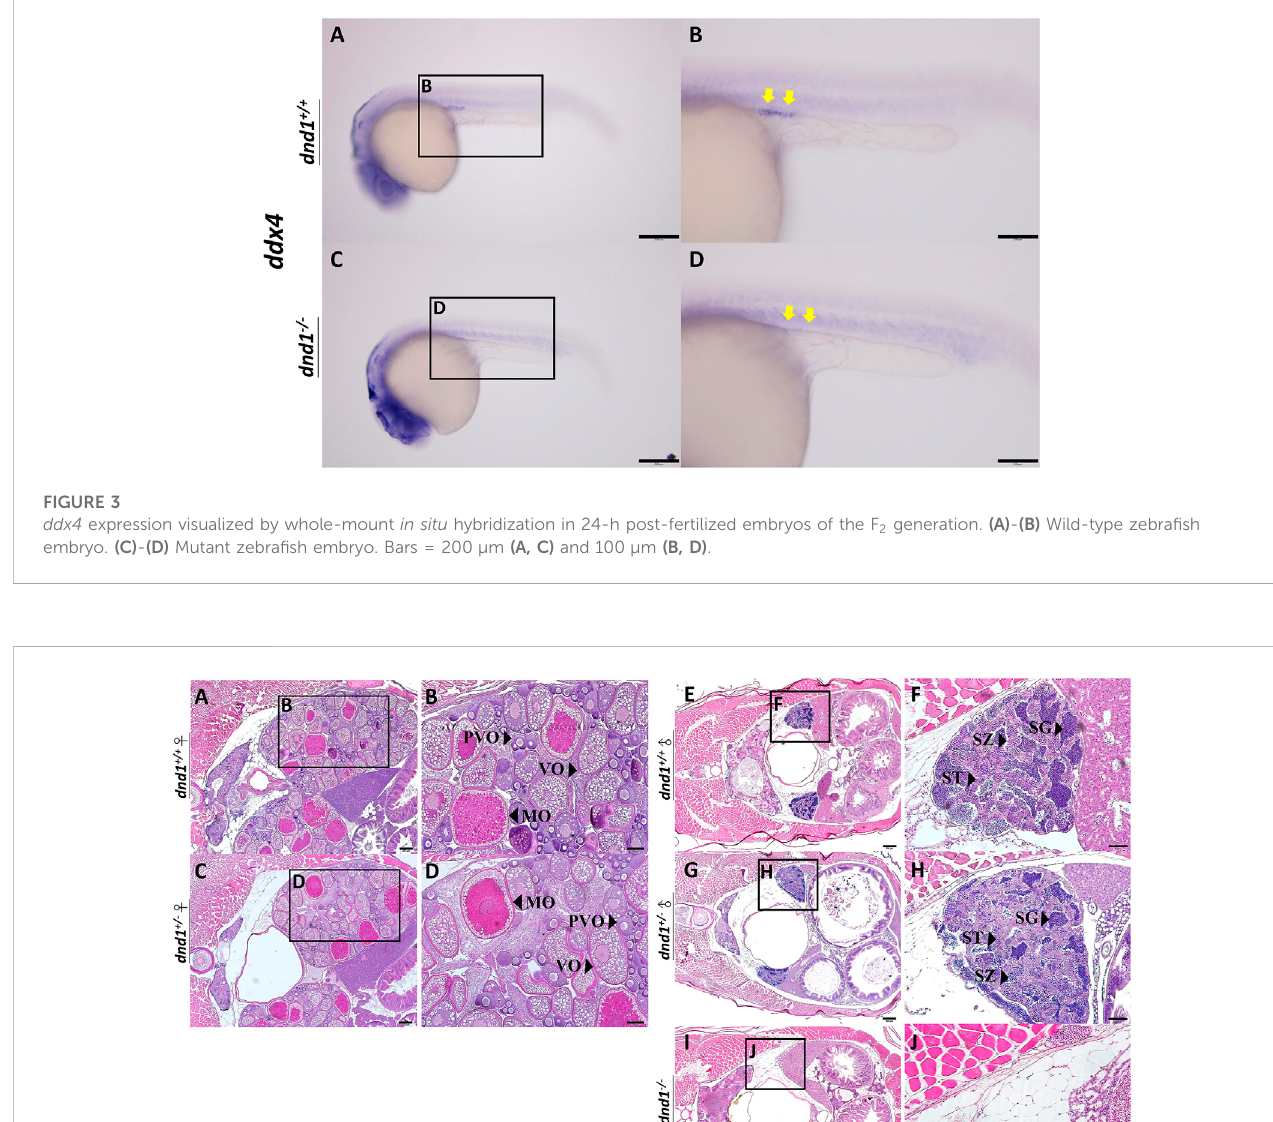
FIGURE 4 Histological analyses of zebra fi sh gonad. (A) - (B) Wild-type zebra fi sh ovary. (C) - (D) Heterozygote zebra fi sh ovary. (E) - (F) Wild-type zebra fi sh testis. (G) - (H) Heterozygote zebra fi sh testis. (I)-(J) Mutant zebra fi sh testis. PVO: previtellogenic oocytes; VO: vitellogenic oocytes; MO: mature oocyte; SC: spermatocytes; SG: spermatogonia; ST: spermatids. Bars = 200 μ m (A, C, E, G, I) , 100 μ m (B, D) and 50 μ m (F, H, J)